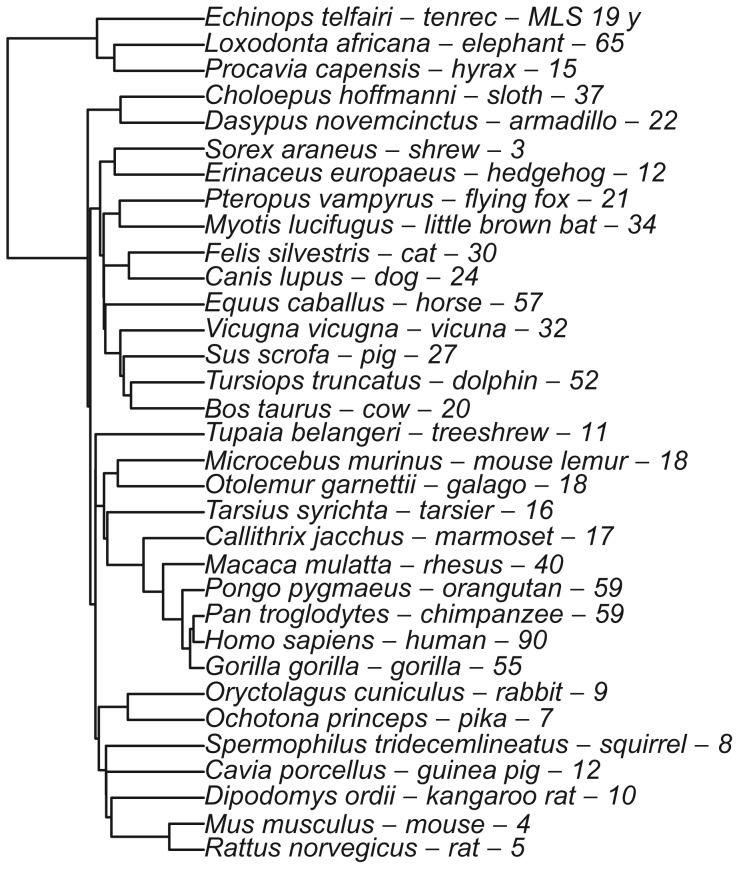
Phylogeny of species used in this study.Shown next to each species’ node are its binomial, common name, and MLS.